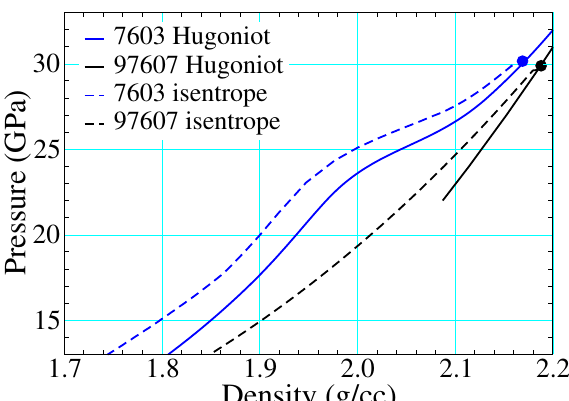
Figure 17. Principal Hugoniots and release isentropes (originating from a shocked state above the threshold for chemical decomposition) as read from SESAME EOS 7603 and 97607. Please note that the structure built into the cold curve of 7603 (see Figure 15, right) is retained also in the